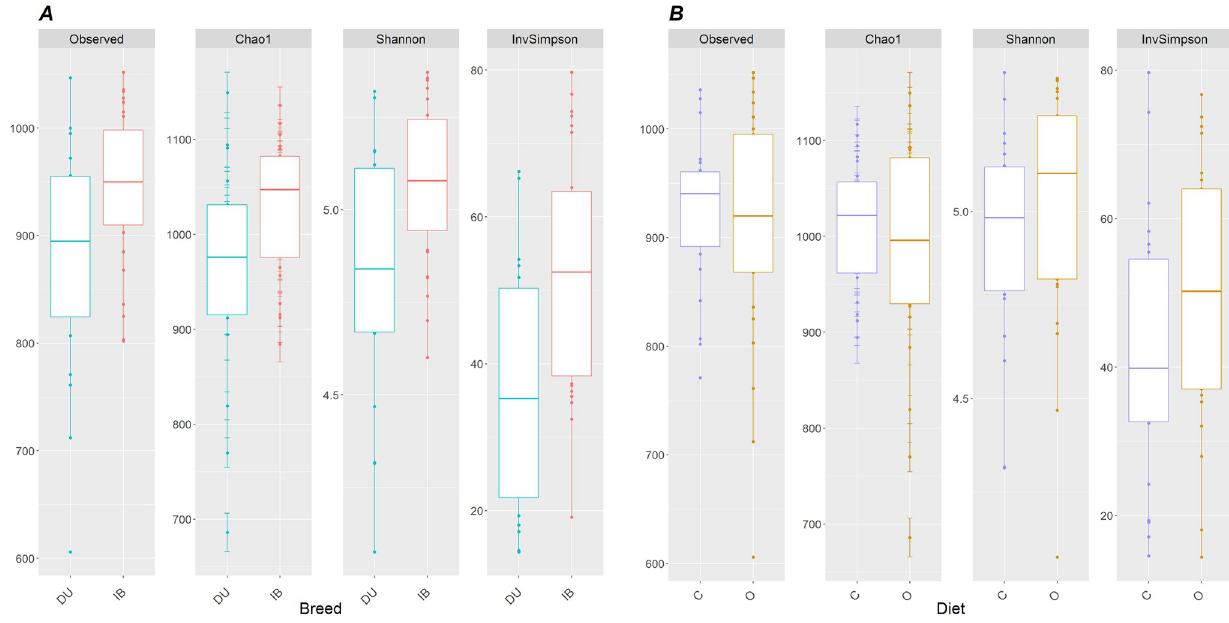
Fig 2. α -diversity boxplots. Alpha-diversity boxplots according to breed (left) and diet (right) groups in rarefied